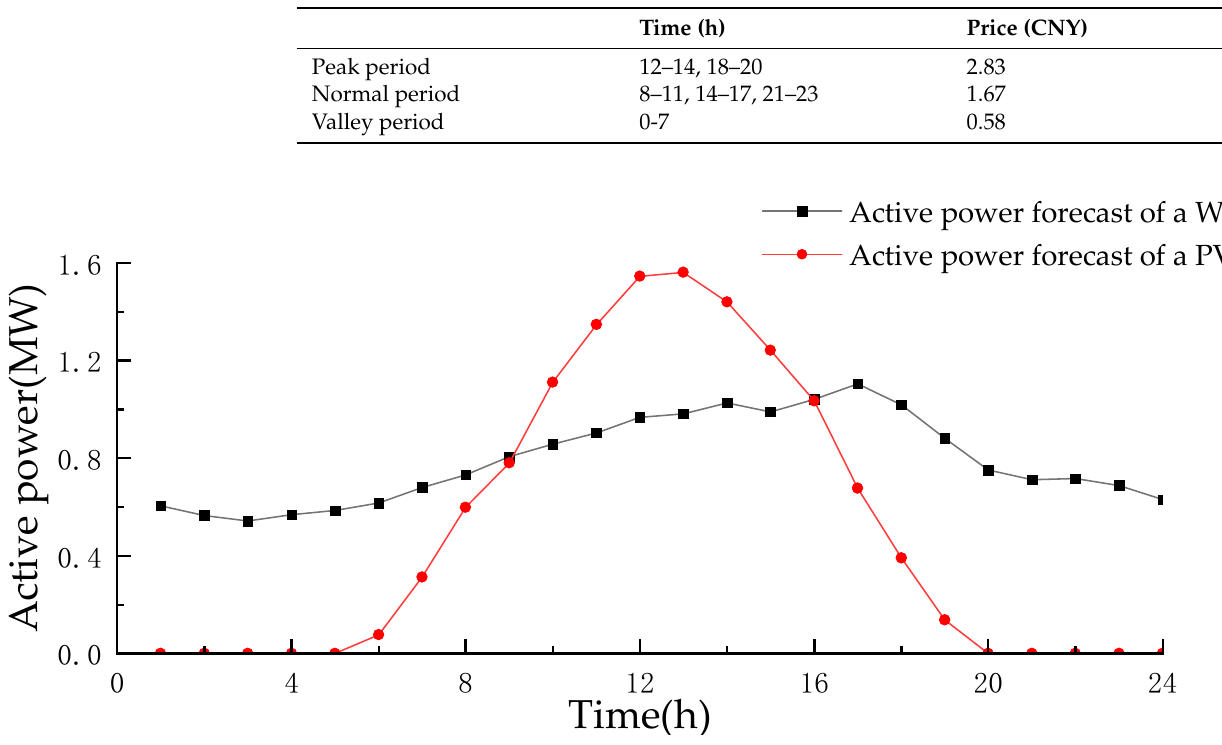
Figure 2. The IEEE 33-node electricity distribution grid and 20-node Belgian gas network. Table 1. Time-of-use electricity price.